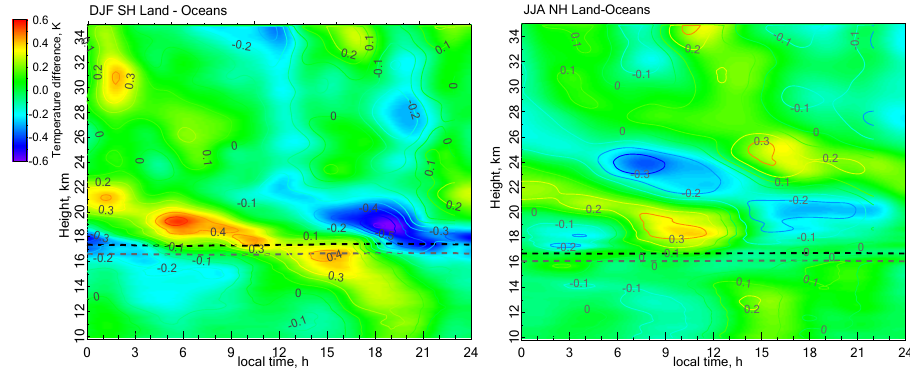
Fig. 3. Difference between diurnal temperature anomalies above land and oceans in DJF in the SH (left) and in JJA in the NH (right), where land and oceanic domains are defined as areas of highest and lowest TRMM PR OPF occurrence frequency (Liu and Zipzer, 2005). Black and gray dashed lines denote CPT and LRT levels above land